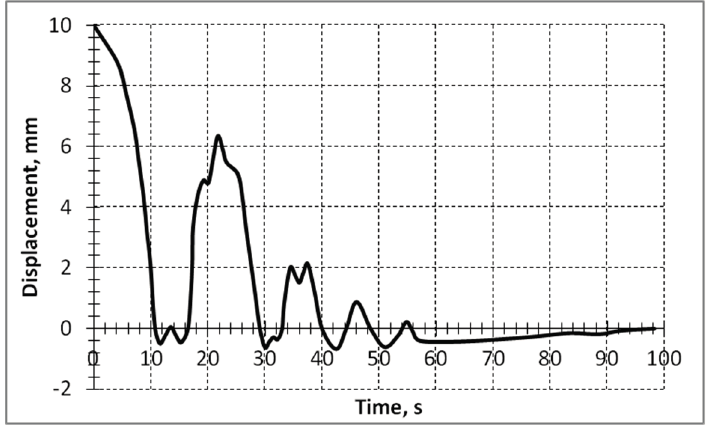
Figure 9. Experimental trajectory of the vibro-impact motion of the cantilever.